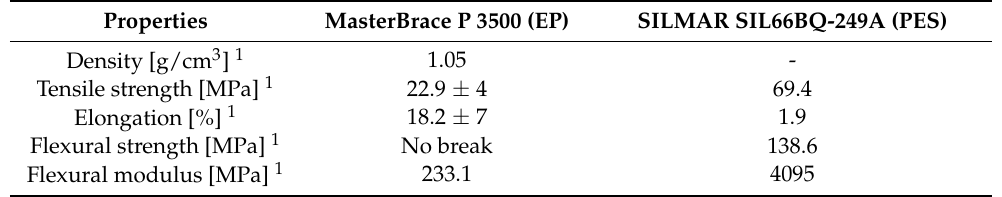
Table 2. Synthetic resin properties.